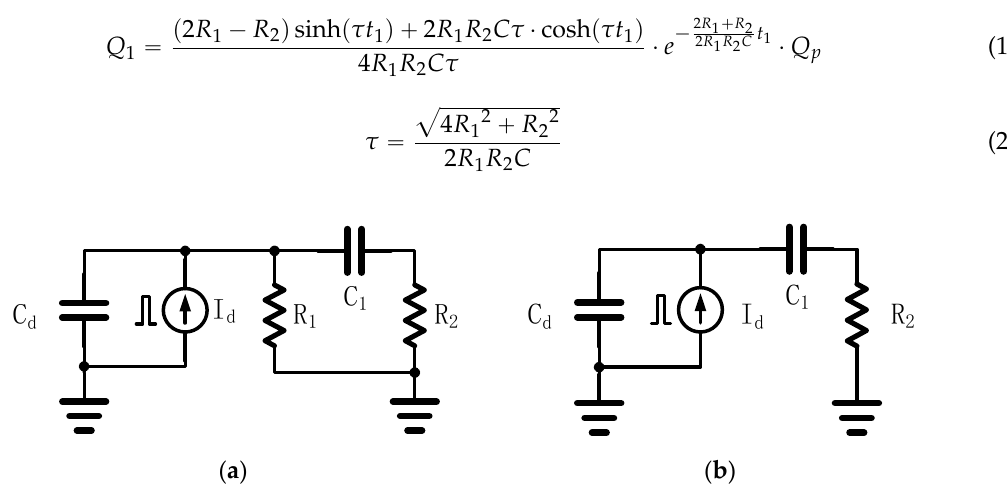
Figure 4. Simplified circuit model of a pixel. ( a ) Before exposure. ( b ) During exposure.